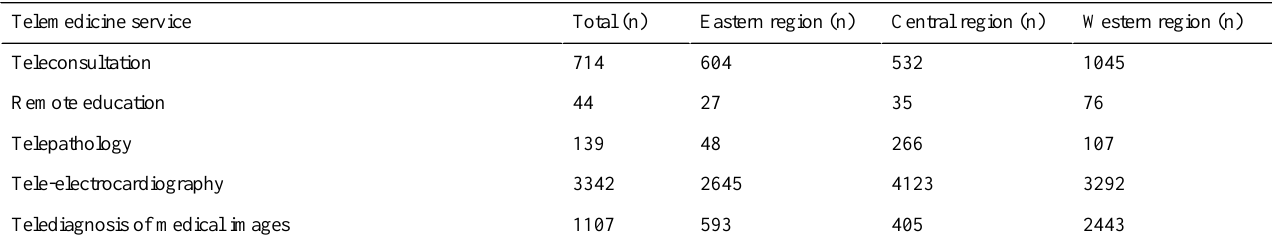
Table 5. Business volume of the major telemedicine services in tertiary hospitals (cases per hospital) in different regions of China.